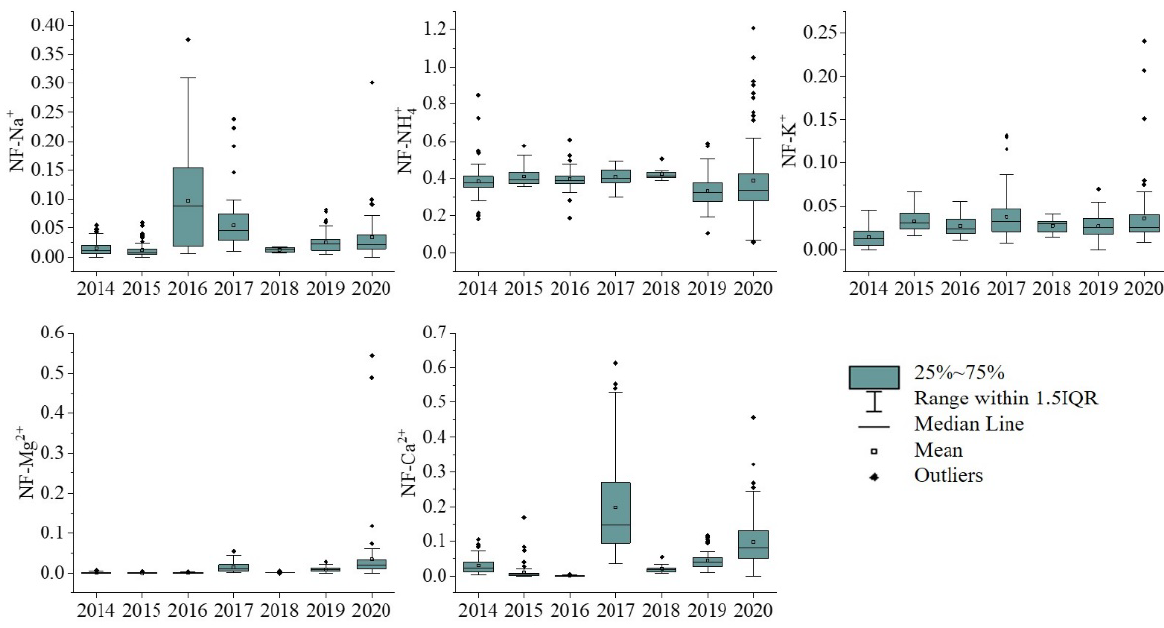
Figure 3. Changes in the neutralization factor (NF xi ) during the summers of 2014–2020. The NH 4+ neutralization factor fluctuated little in summer 2015, 2016, and 2017. In 2014, except for a sharp increase on 20 June to 0.8, the remaining days exhibited relatively stable values that fluctuated around 0.4. In August 2019 and 2020, the NH 4+ neutralization factor fluctuated. The NH 4+ neutralization factor in June 2014 was larger than that in July and August. The NH 4+ neutralization factor in August 2020 was smaller than that in June and July. The NH 4+ neutralization factor in June and July 2020 was larger than that of other years in the same period, but that in August was smaller than that of other years in the same